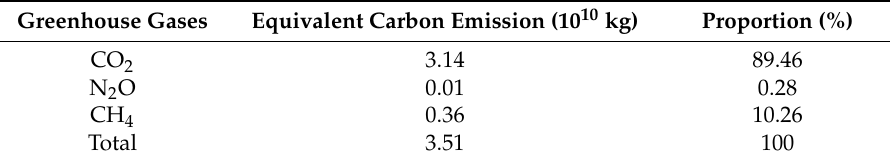
Table 8. Structure of emitted greenhouse gases in the coal supply